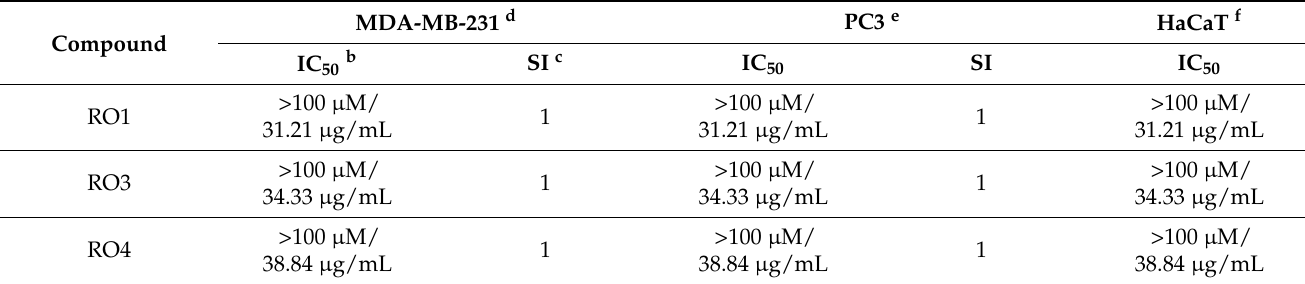
Table 3. Cytotoxic activity (IC 50 µ M/ µ g/mL) of the studied compounds estimated by the MTT assay a